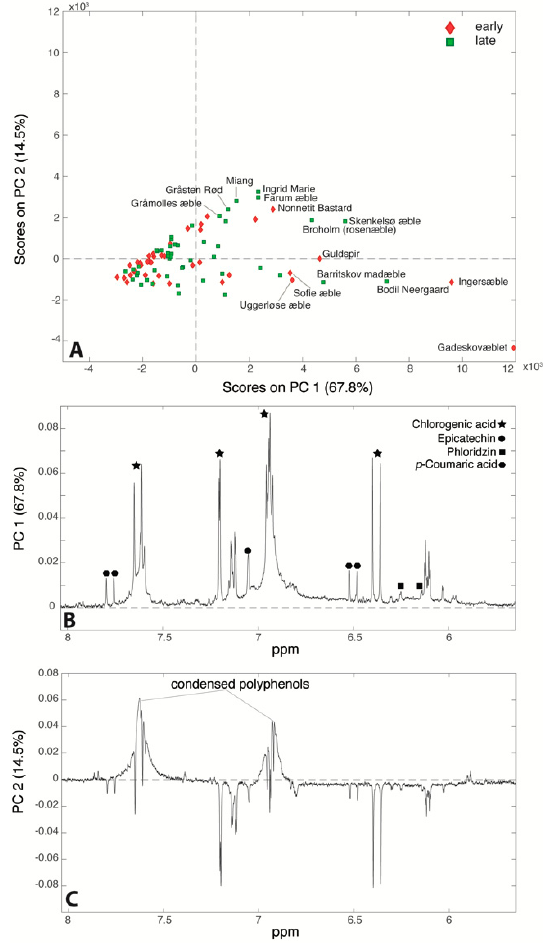
Figure 7. Score plot ( A ) and PC1 ( B ) and PC2 ( C ) loading plots of the principal component analysis (PCA) performed on the 1 H-NMR spectra of the 86 apple juices under study.